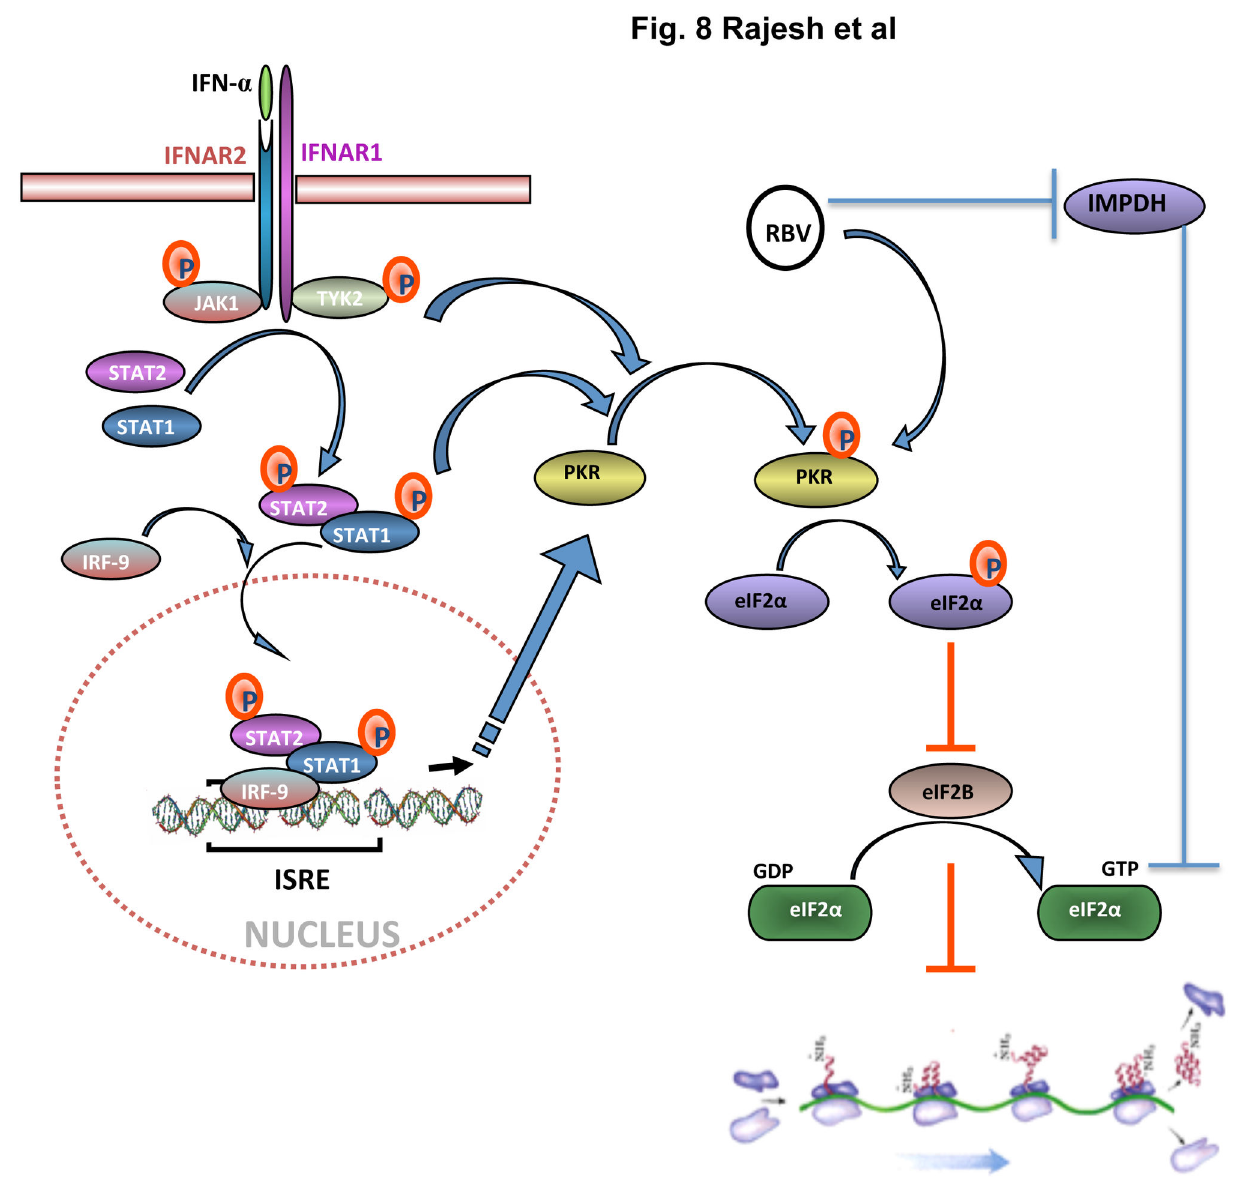
Figure 8. Diagram summarized the proposed IFN-α and RBV synergy antiviral mechanisms against HCV IRES-GFP translation. IFN-α binds to the cell surface receptor, which activates the cellular Jak-Stat pathway leading to the activation of PKR. The activated PKR phosphorylates the eIF-2α. Phosphorylation of eIF-2α inhibits the recycling of initiation factors and translation initiation. On the other hand, RBV activates the PKR and eIF2 α phosphorylation and inhibits the translation initiation. Ribavirin inhibits HCV IRES translation by inhibiting IMPDH and GTP pool.